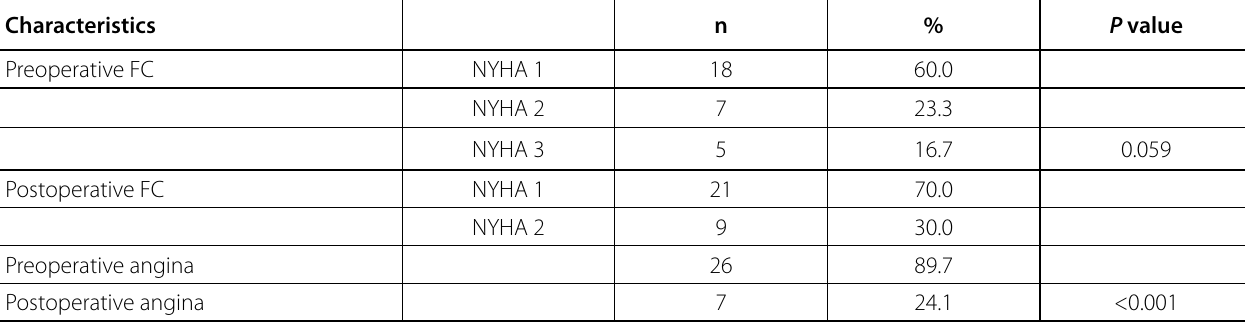
Table 2 . Preoperative and postoperative distribution and comparison of patient symptoms and functional capacity values.